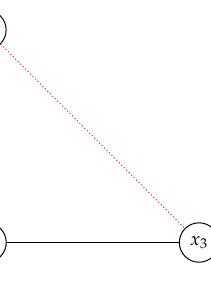
Figure 2. The edge colored graph derived when solving MaxCut on a triangle.The solid black is one color class, and red densely dotted and blue dashed are the other two. There are three colors needed to properly edge color this graph, so the unitary circuit depth is four.